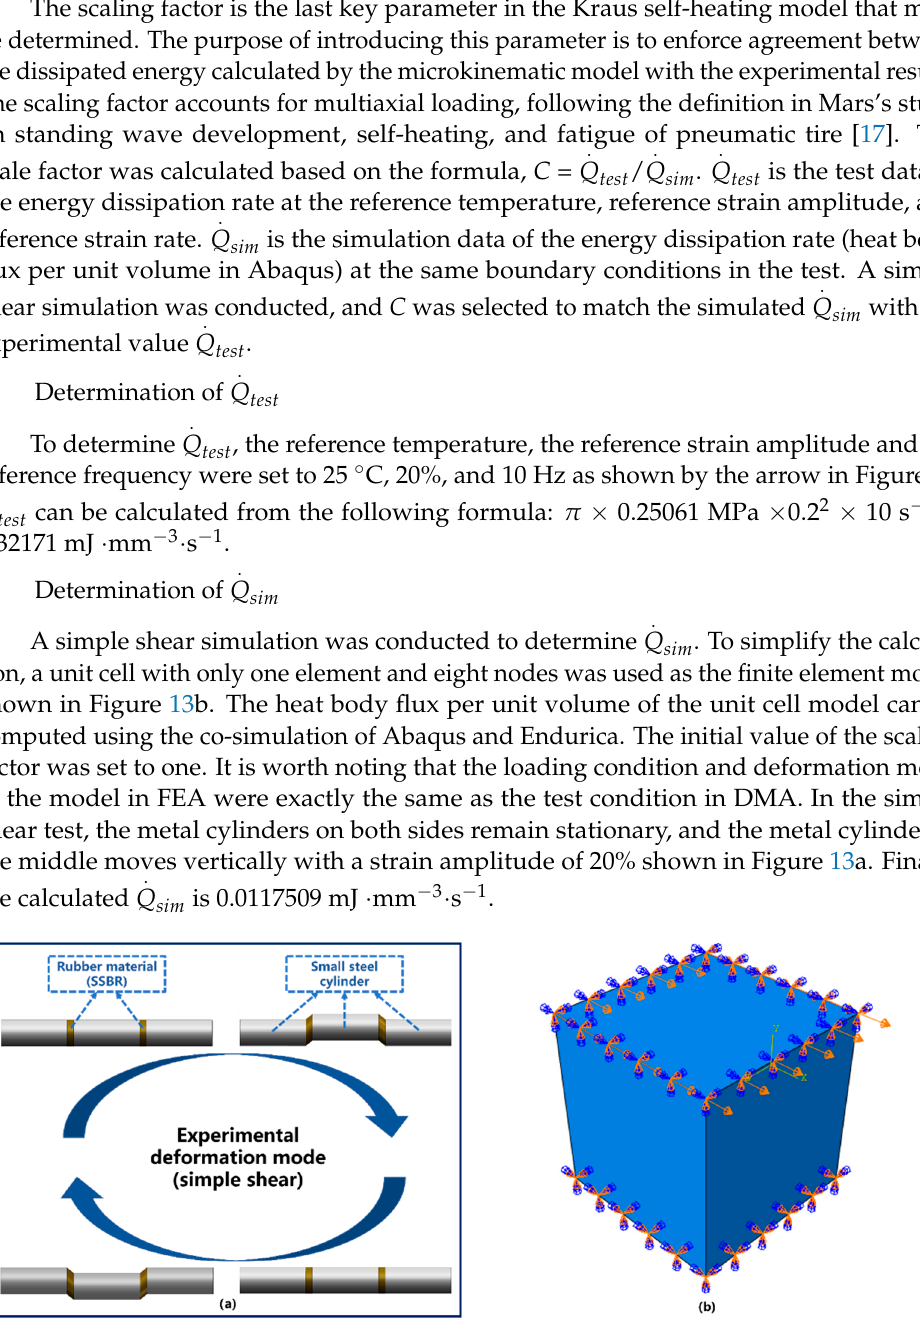
Figure 13. ( a ) The deformation mode of the specimen and the deformation of the material during the DMA test. ( b ) An eight-node element model for simulation, and its deformation